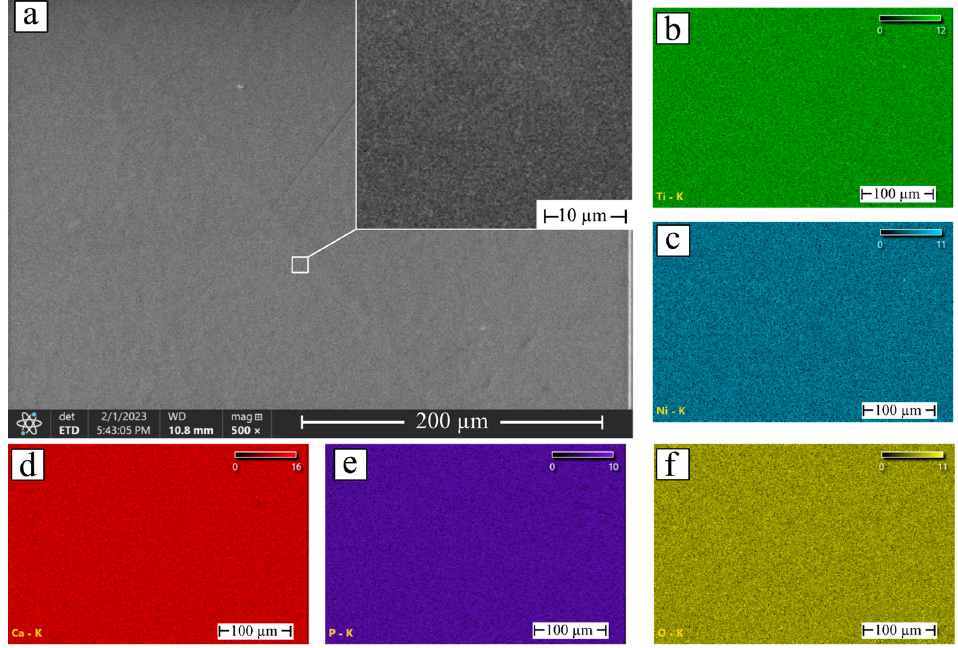
Figure 4. ( a ) SEM image of the NiTi with hydroxyapatite coating deposited for 3 h and elemental maps of: ( b ) Ti; ( c ) Ni; ( d ) Ca; ( e ) P; and ( f ) O.